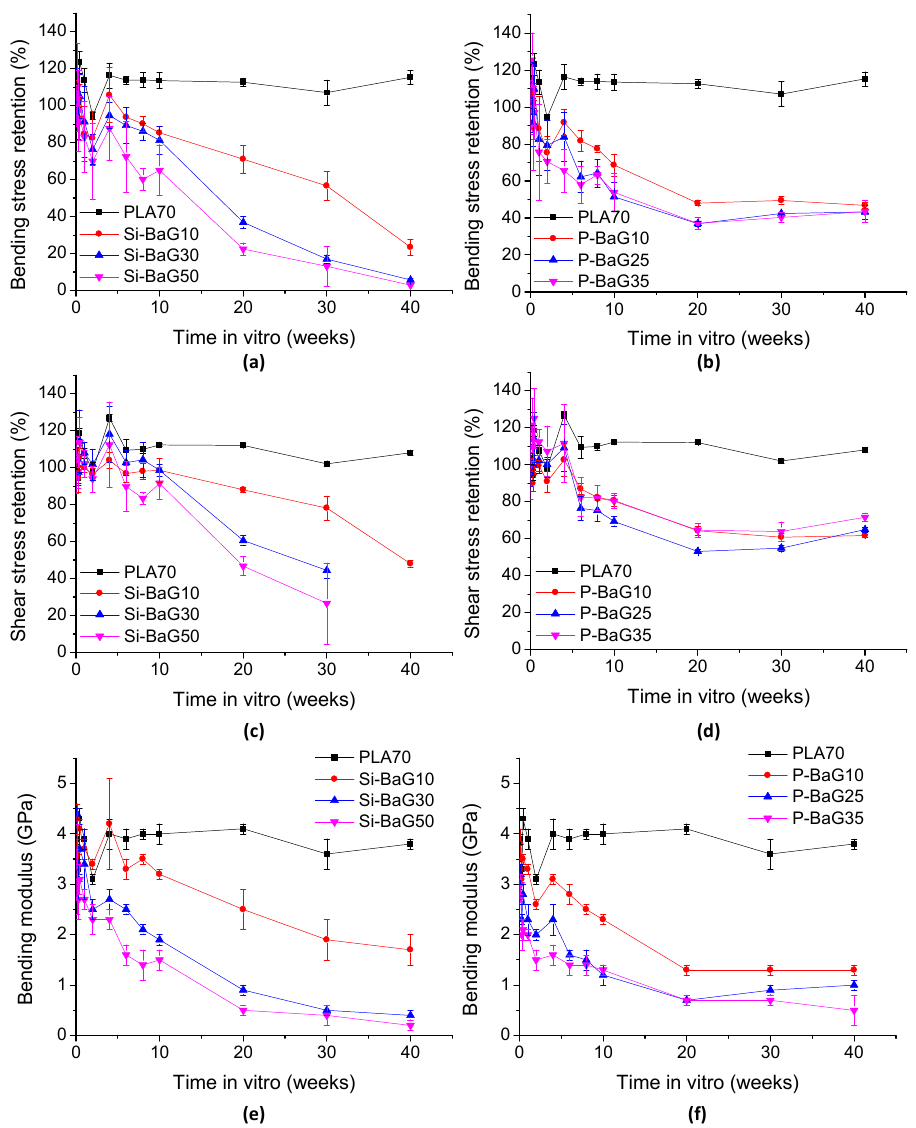
Figure 9. Bending and shear strength retention and bending modulus of PLA70 and the composites with ( a ), ( c ), ( e ) Si-BaG and ( b ), ( d ), ( f ) P-BaG over a period of 40 weeks in vitro.